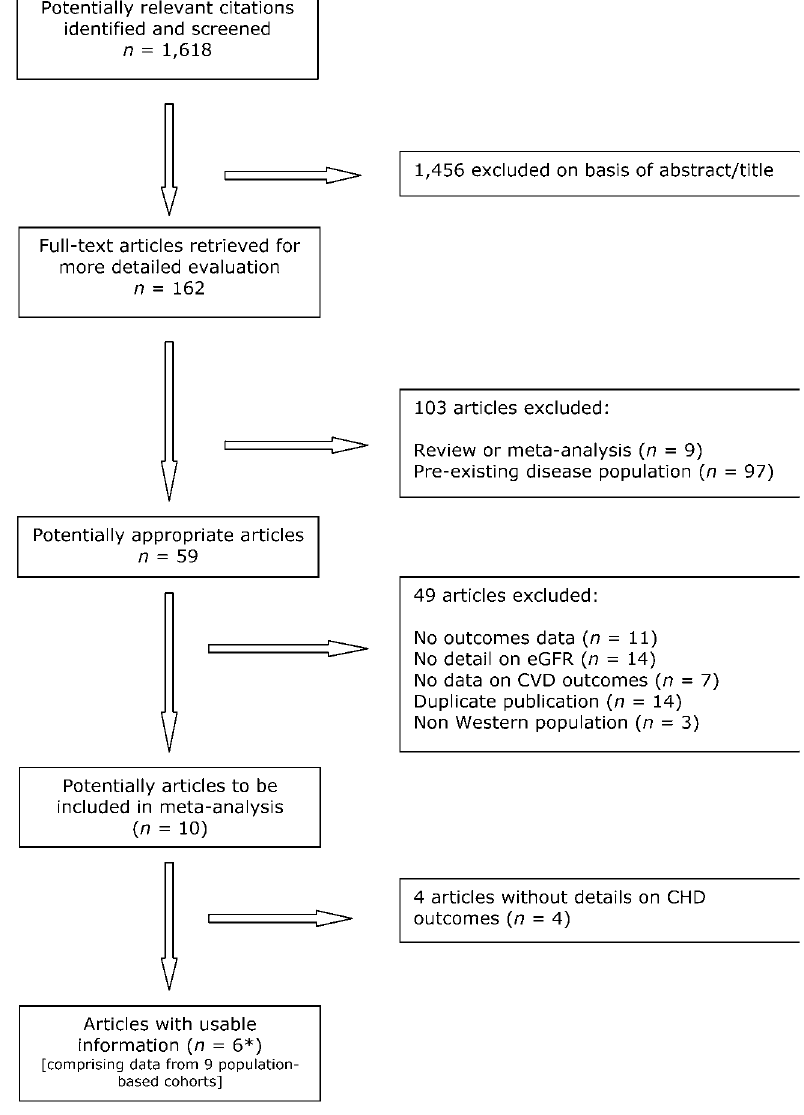
Figure 1. Summary of Meta-Analysis